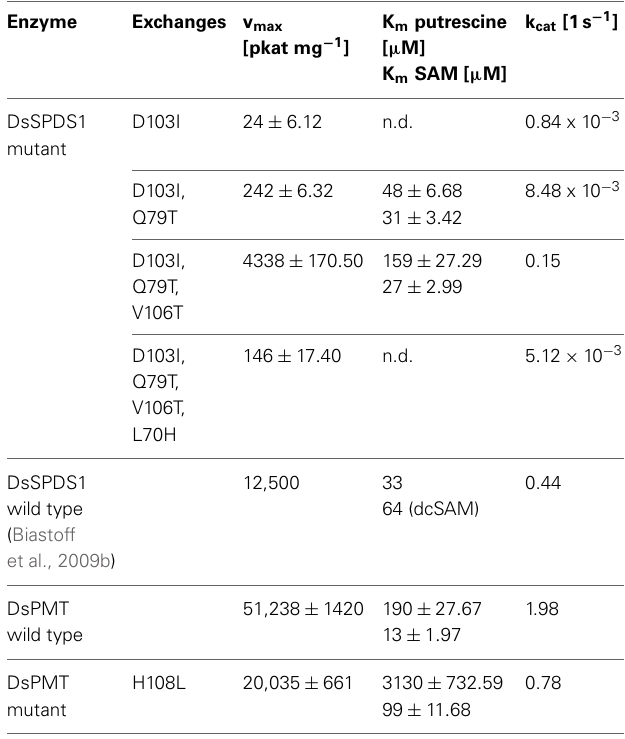
methyltransferase activity was detected after D103I exchange with a k cat of less than 0.04% of the DsPMT wild type. The sec- ond replacement in DsSPDS1, Q79T, increased the PMT activity to 0.00848 reactions s − 1 , i.e., 0.5 reactions min − 1 . Thus, only